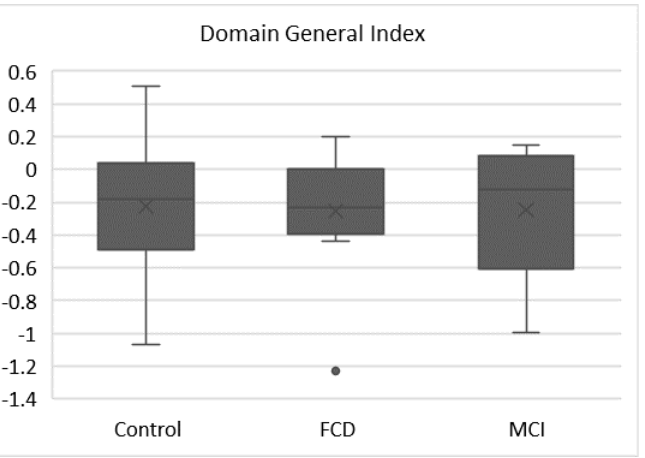
Figure 2. Domain General Index. The DGI is calculated as: [log (Meta-d’/d’)Perceptual] minus [log(Meta- d’/d’)Memory].